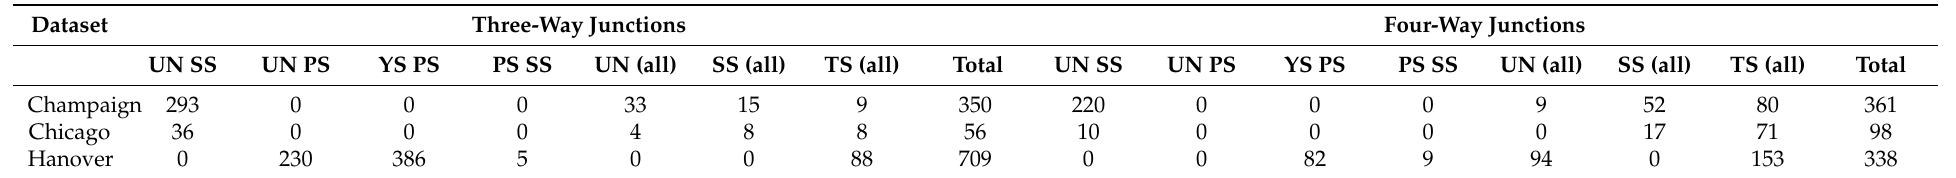
Table 3. Combinations of traffic regulators at intersections. In Champaign and Chicago there are UN/SS controlled junctions, all-way UN controlled junctions, all-way SS, and all-way TS controlled junctions. In Hanover, there are UN/PS, YS/PS, all-way UN, and all-way TS controlled